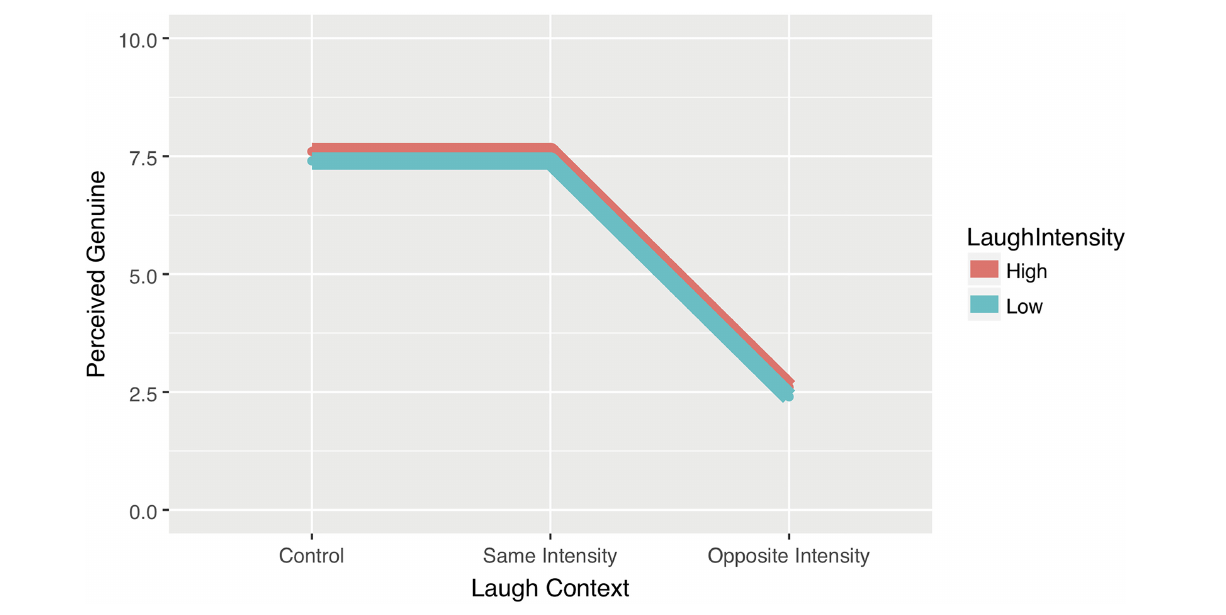
Frontiers in Psychology |